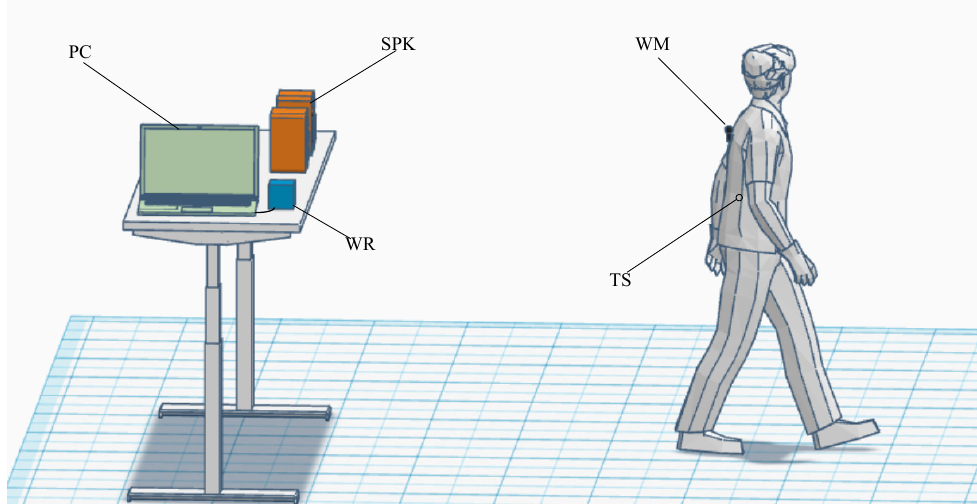
Figure 1. Proposed system configuration for walking-speed measurement. The personal computer (PC) supervises the operation of the system. Proper sound pulses are generated and diffused by the speaker (SPK); such pulses are detected by the wireless microphone (WM) worn by the test subject (TS) and, by way of the wireless receiver (WR), are sent back to the PC that recovers the distance by evaluating the sound propagation delay from the speaker to the microphone.